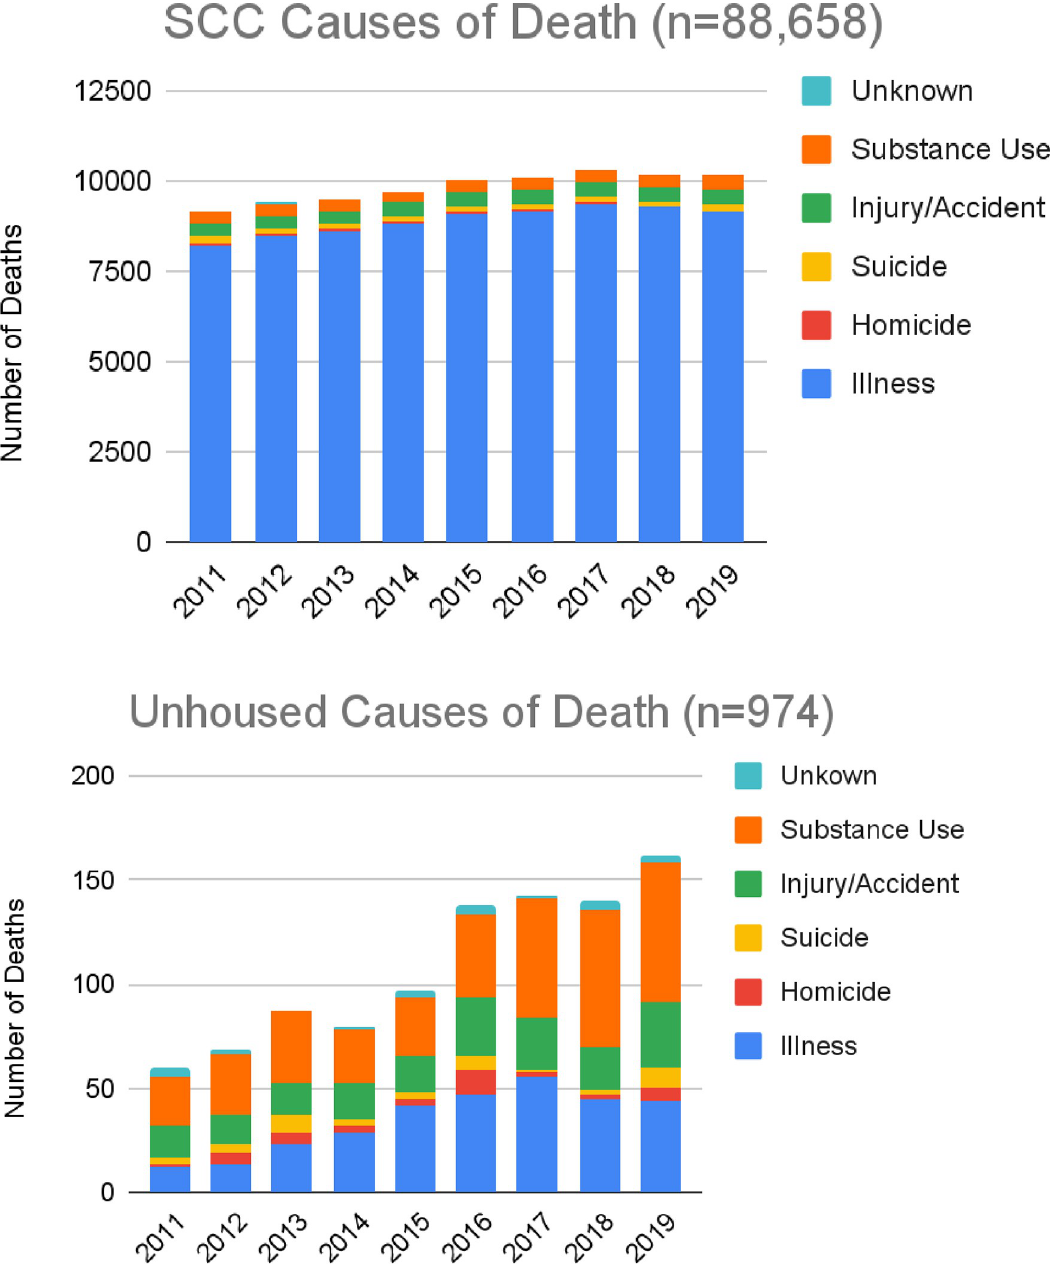
Fig 2. Number of deaths per year for the general population and the Santa Clara County (SCC) unhoused population between 2011–2019, displayed by cause of death categories. Illness. In the general population, 90.4% of deaths were due to illness (95% CI: 90.2%, 90.6%), whereas 32.0% of unhoused people’s deaths were due to illness (95% CI: 29.1%, 35.1%). Among unhoused people’s deaths caused by illness, the top CODs were cardiovascular diseases (46.8%, n = 146), respiratory diseases (12.2%, n = 38), and cancer (8.3%, n = 26). Com- municable diseases (4.8%, n = 15), diabetes (4.8%, n = 15), and cerebrovascular diseases (4.5%, n = 14) were notable.